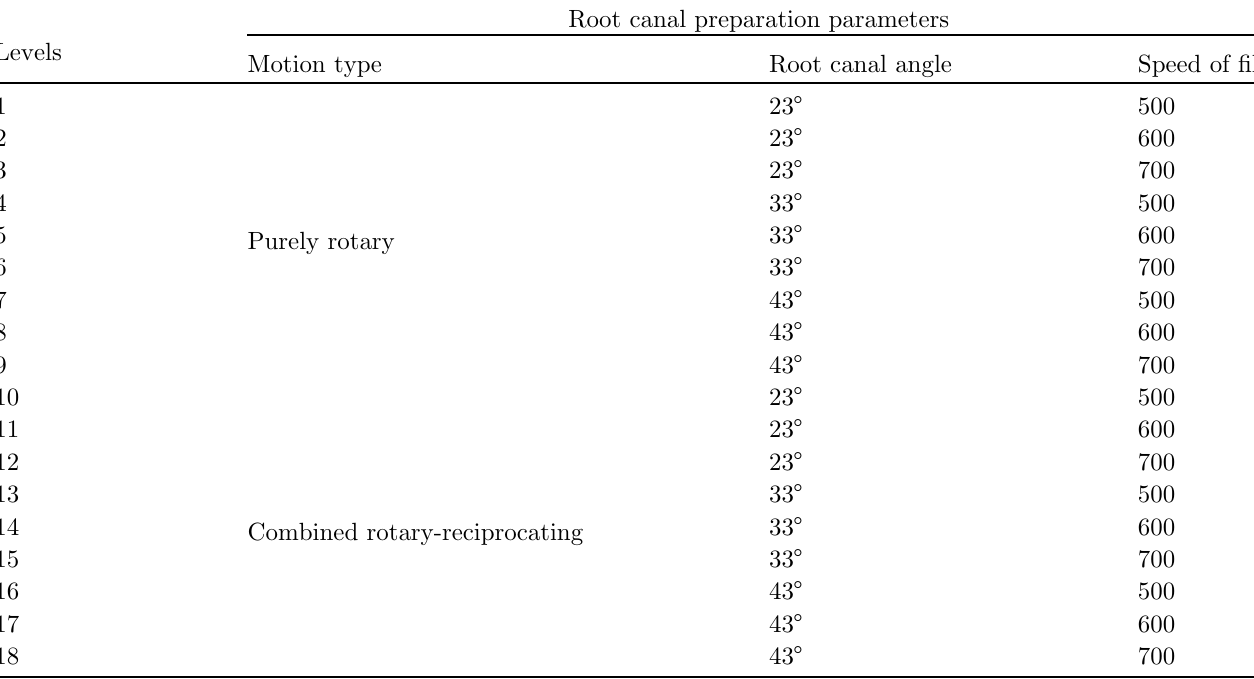
Table 6. Experimental design with contributing